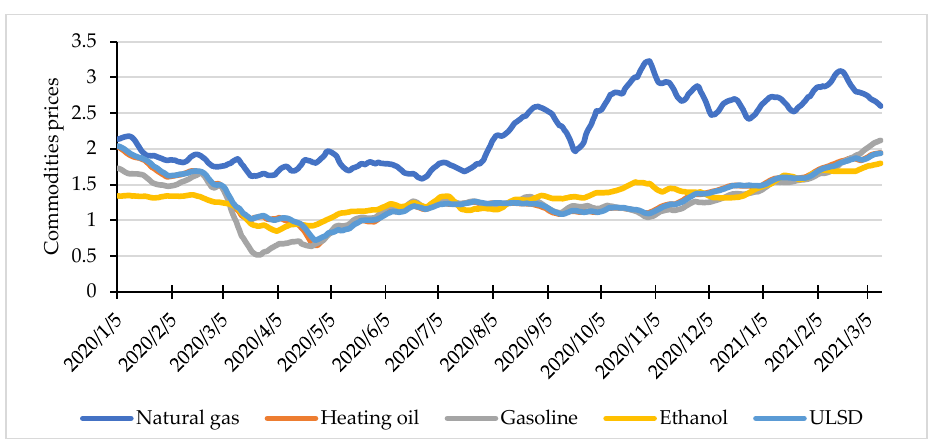
Figure 1. CO 2 allowances, crude oil, coal, uranium, and palm oil prices. Source: own elaboration on the basis of data from www.stooq.com (accessed on 19 April 2021).